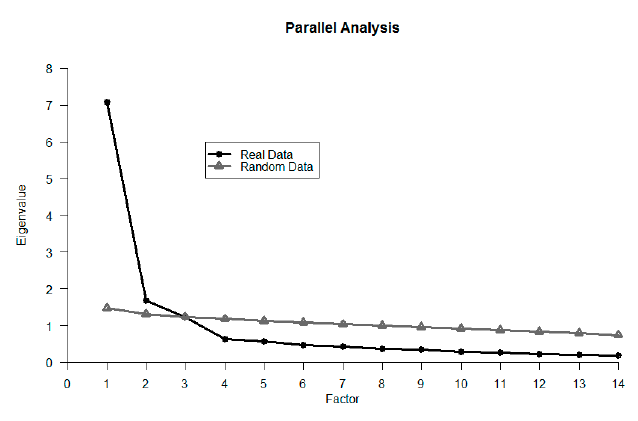
Figure 1. Parallel analysis of the Public Bathroom Perception Scale.